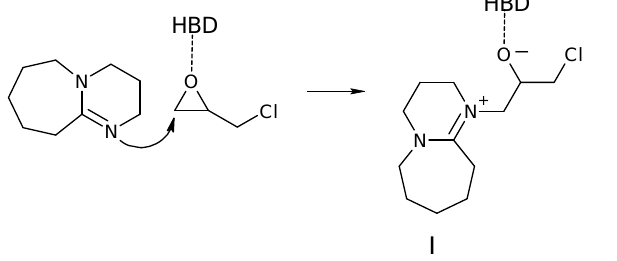
Figure 4. Activation of the epoxide by DES composed of DBU as a HBA proposed by García-Argüelles et al. [53].